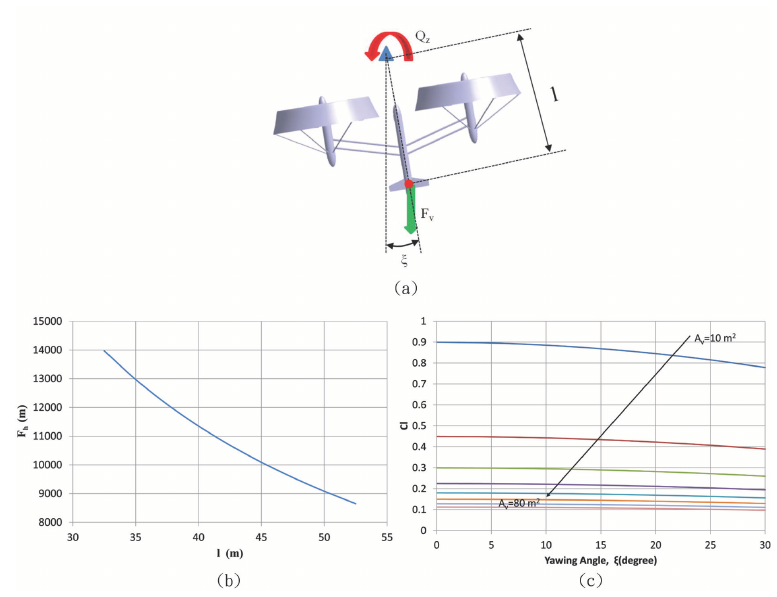
Figure 19. ( a ) Schematic for the yawing balance; ( b ) distance from the center of force to the anchoring point versus the required force exerted on the vertical tail fin; ( c ) yawing angle and lift coefficient vs. the required effective vertical area of force.